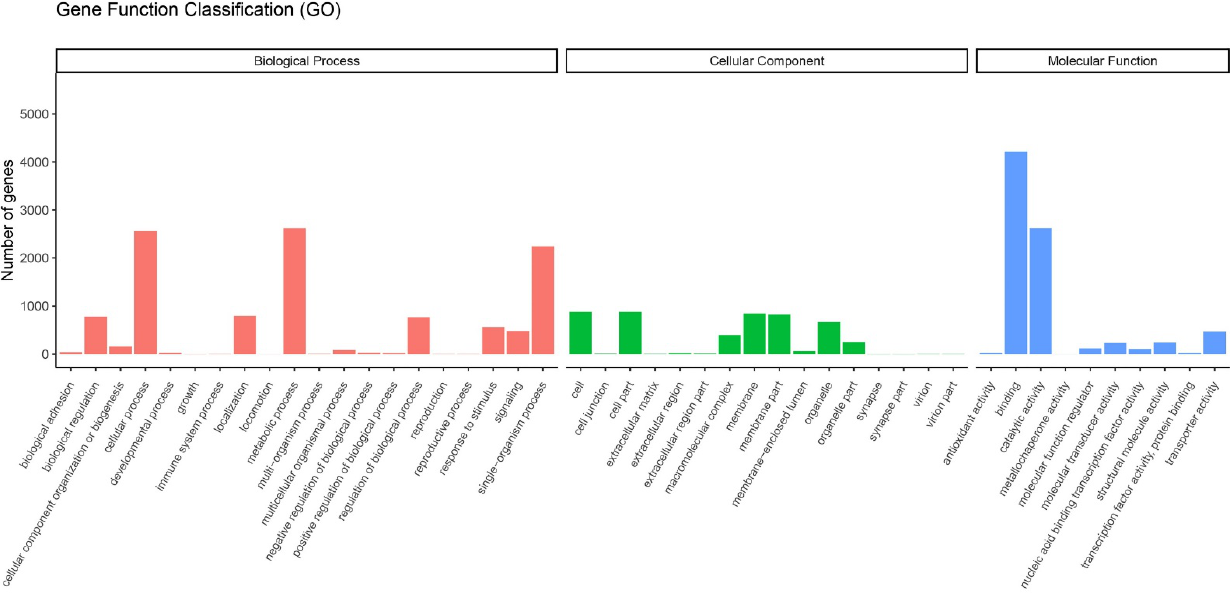
Figure 5. Venn diagram of gene numbers and distribution of 5 different hosts pairwise compared with AD.